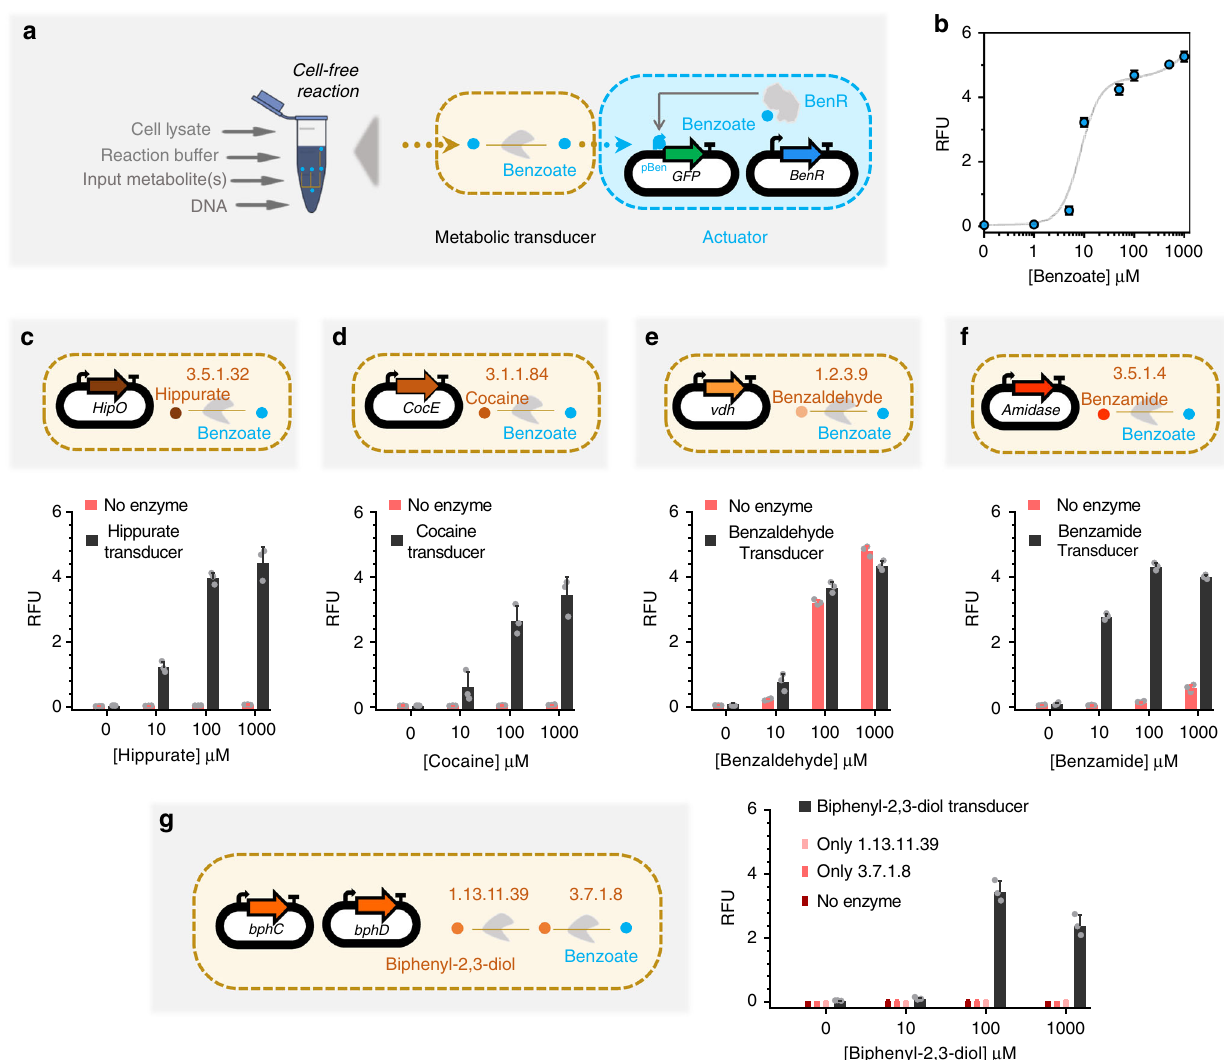
Fig. 3 Cell-free actuator and metabolic transducers. a Implementing benzoate actuator and transducers in E. coli transcription/translation (TXTL) cell-free system. Cell-free reactions are composed of cell lysate, reaction buffer (energy source, tRNAs, amino acids, etc.) and DNA plasmids. b Dose – response plot of the benzoate actuator in the cell-free system with 30 nM of TF-plasmid (constitutively expressed BenR ) and 100 nM of reporter plasmid ( pBen-sfGFP ) per reaction. The data points represent the dose – response of the actuator to different concentrations of benzoate and the gray curve is a model- fi tted curve on actuator data c – g . Cell-free transducers coupled with the benzoate actuator for hippurate ( c ), cocaine ( d ), benzaldehyde ( e ), benzamide ( f ), and biphenyl-2,3-diol ( g ), which is composed of two enzymes. All enzymes are cloned in a separate plasmid under the control of a constitutive promoter J23101 and RBS B0032. 10 nM of each plasmid was added per reaction. The bars are the response of the circuits to different concentrations of input with (transducers, black bars) and without enzyme (red bars). All data are the mean and the error bars are the standard deviation of normalized values from measurements taken from three independent cell-free reactions on the same day (gray dots on each bar are individual values from which the mean and SD were calculated). (RFU relative fl uorescence unit). Source data are provided in the Source Data fi